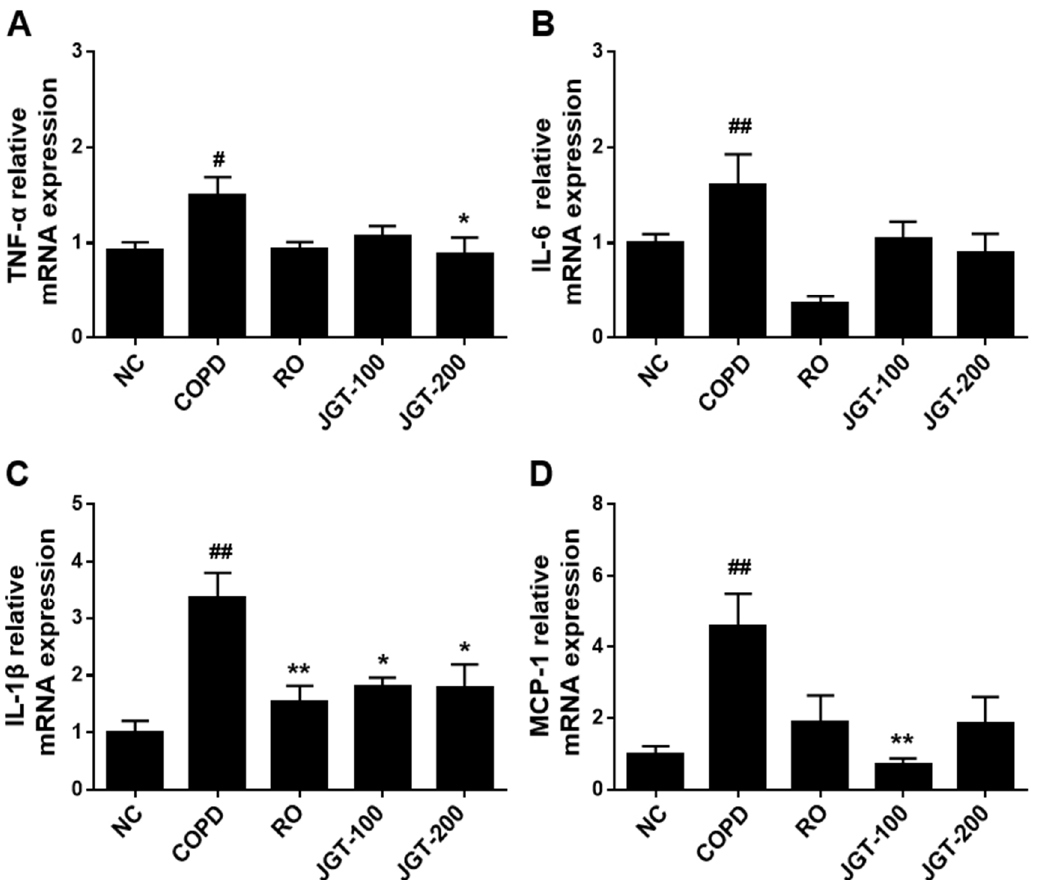
Figure 6. Effects of JGT on the concentrations of mRNAs encoding the proinflammatory cytokines ( A ) TNF-α, ( B ) IL-6, ( C ) IL-1β, and ( D ) MCP-1 in lung tissue, as measured by real-time RT-PCR. NC, normal control mice; COPD, CS & LPS-treated mice; RO, roflumilast (5 mg/kg) along with CS & LPS-treated mice; JGT-100, JGT (100 mg/kg) along with CS & LPS-treated mice; JGT-200, JGT (200 mg/kg) along with CS & LPS-treated mice. Data are displayed as means ± SEM. # p < 0.05 and ## p < 0.01 compared with NC; * p < 0.05 and ** p < 0.01 compared with COPD.